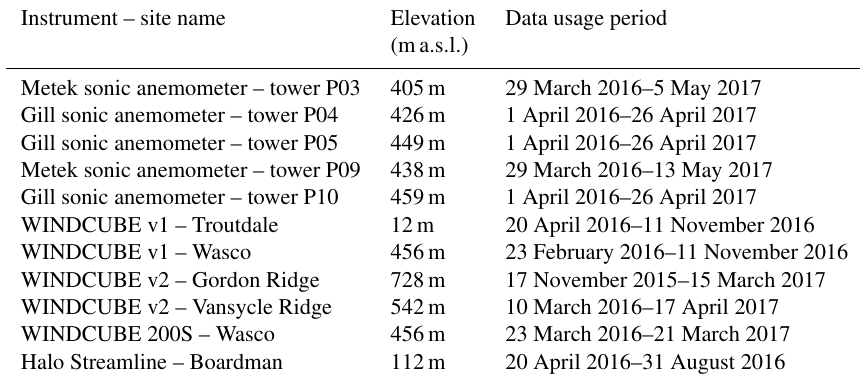
Table 1. Elevation and period of data collection for the five 10m sonic anemometers at the Physics Site, the four profiling lidars, and the two scanning lidars considered in this study, whose locations are shown in Fig.